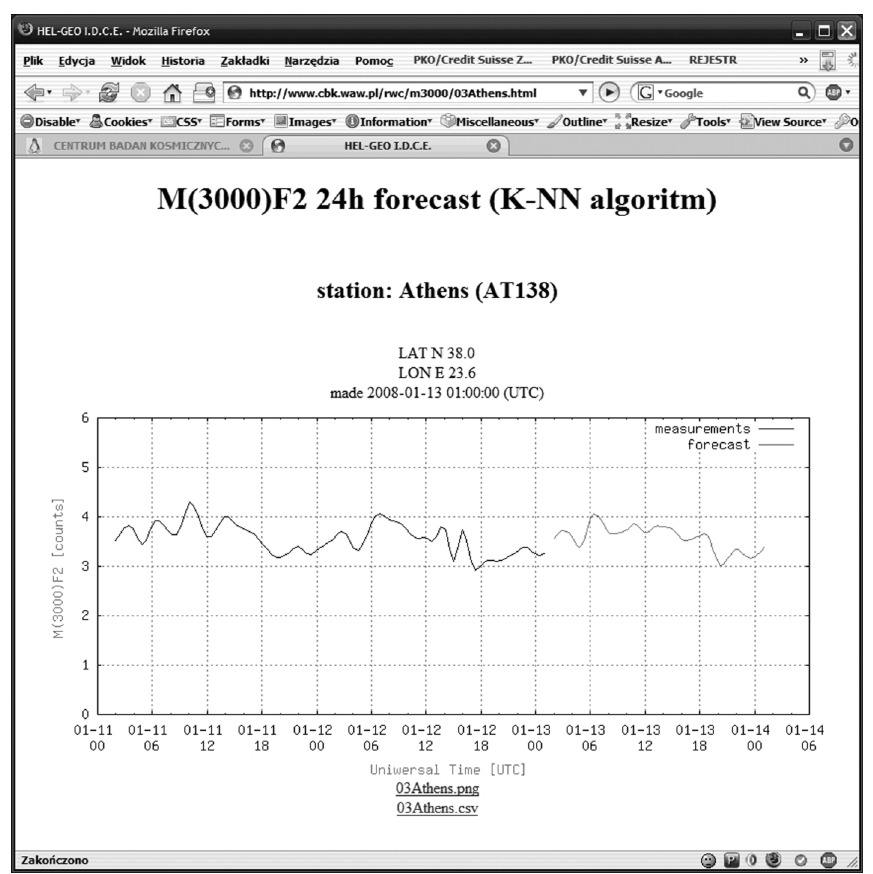
Fig. 5. Sample of M(3000) F2 forecasted service